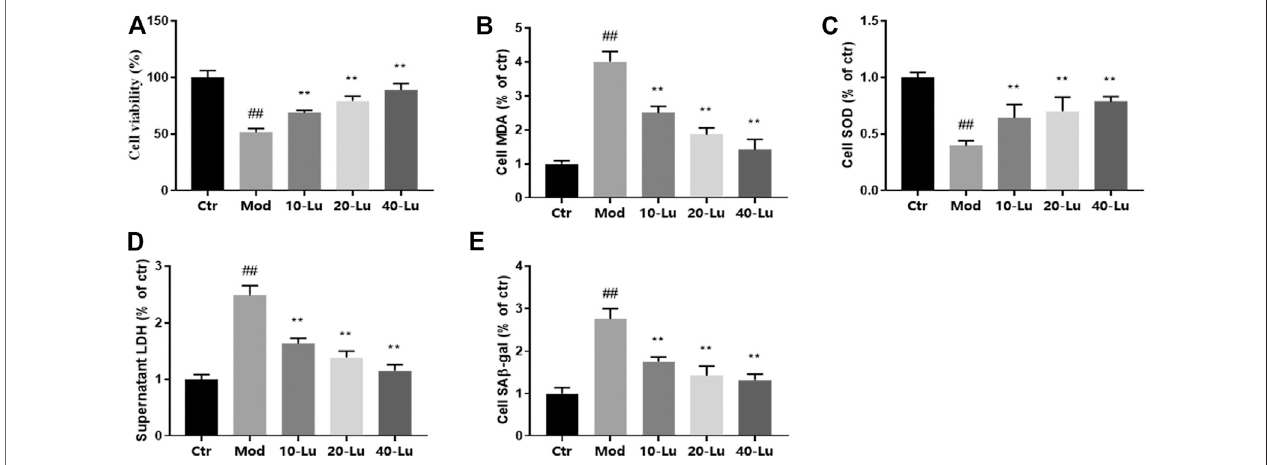
FIGURE 4 | Luteolin improves biochemical parameters on HSF cells exposed to UV radiation. (A) Cell viability at different concentrations of luteolin. (B – D) , The contentsofMDA,SODandLDHinskintissues. (E) luteolindecreasedthecontentofSA β -galofcellsunderUVBirradiation.#indicatessigni fi cantdifferencebetweenthe model group and the blankgroup (# p < 0.05; ## p < 0.01);* indicates signi fi cantdifference betweenthe administered group and themodel group (* p < 0.05; ** p <